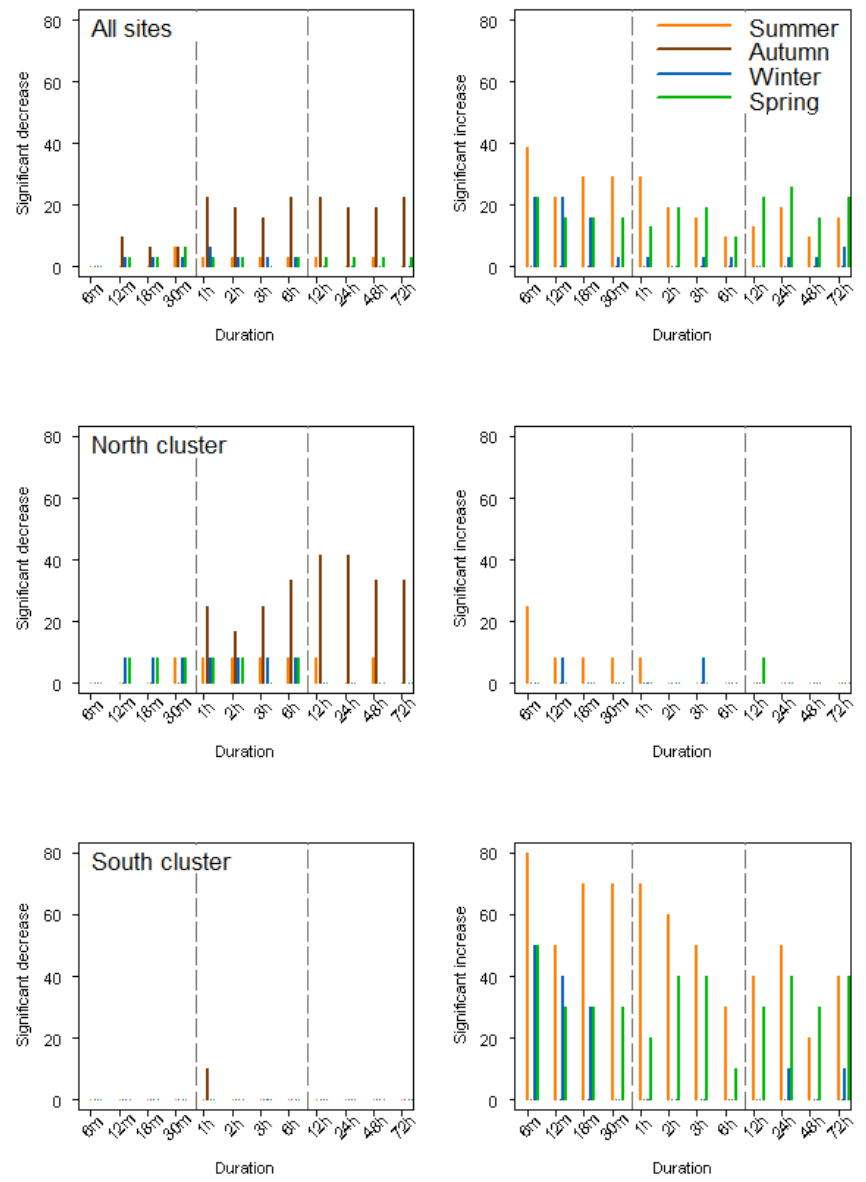
Fig. 3. Percentage of sites with significant changes in frequency from an earlier to a later period (1976–1990 and 1991–2005) based on 12 sites in the north cluster and 10 sites in the south cluster, using POT10